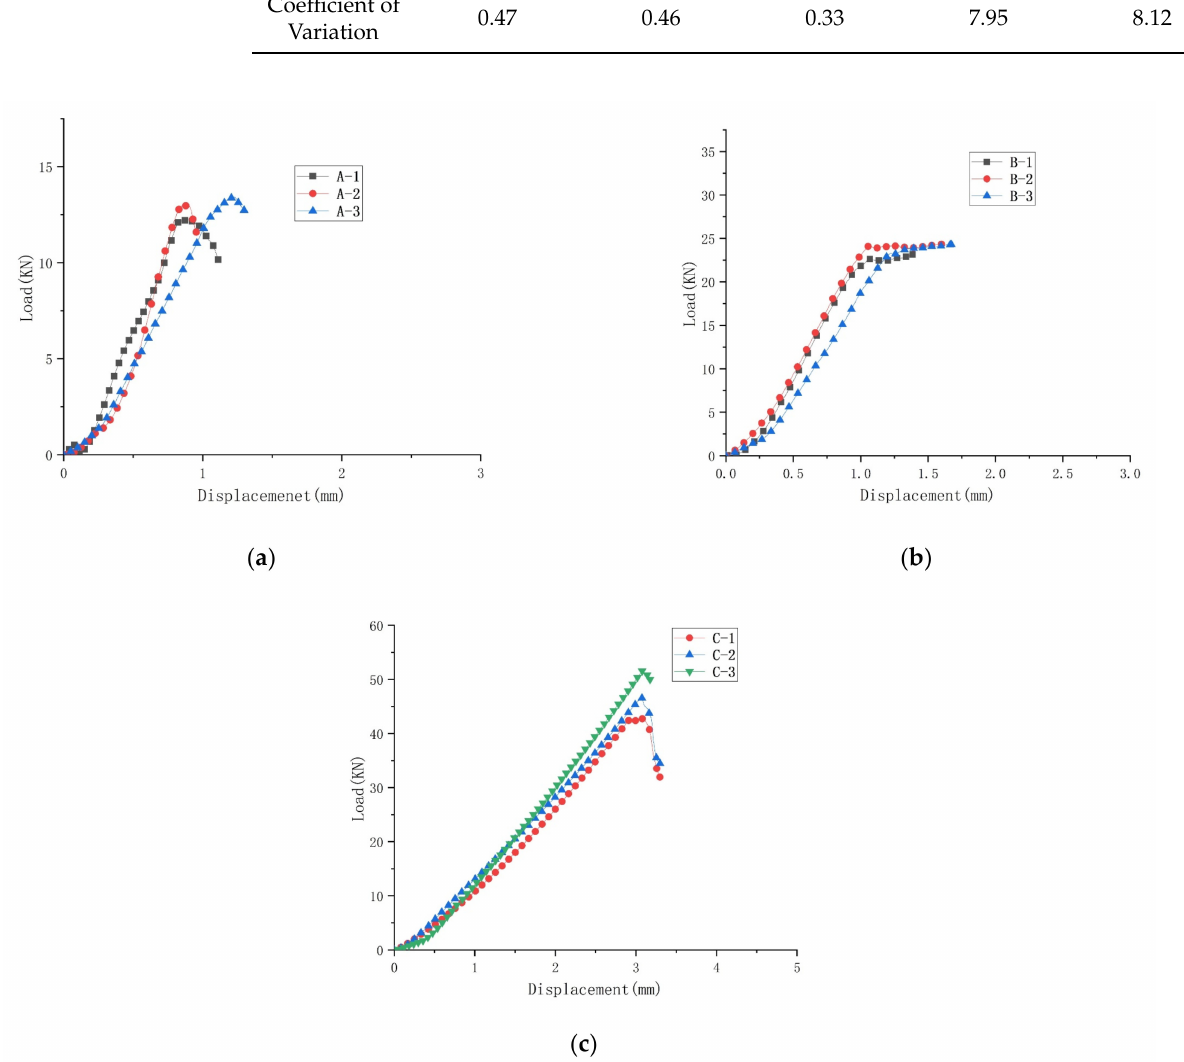
Figure 4. Quasi-static compression load-displacement curves for specimens in the ( a ) warp, ( b ) weft, and ( c ) thickness